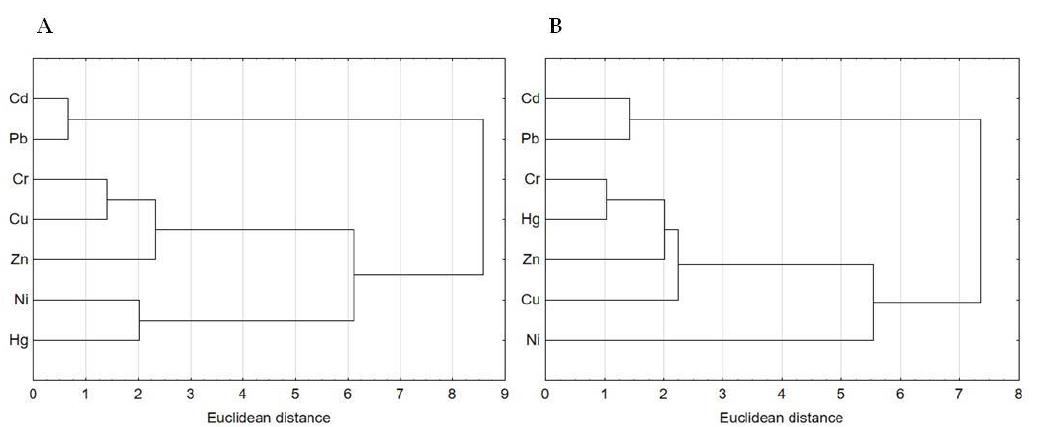
Figure 4. Cluster Analysis (CA) by Ward for thickened ( A ) and dewatered and/or hygienized ( B ) sewage sludge samples.